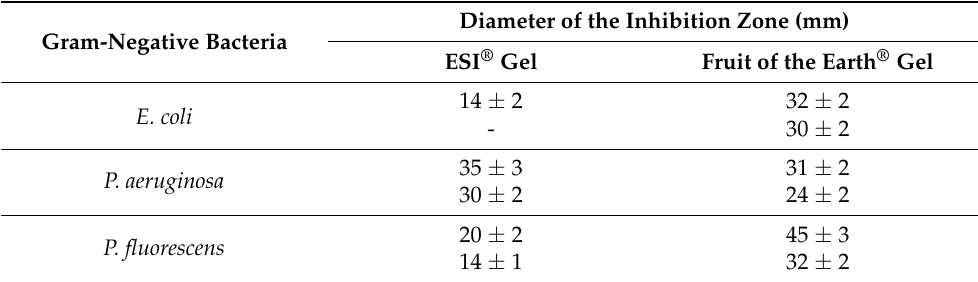
Table 2. Antimicrobial activity of aloes natural and commercial products on Gram-negative bacteria. Diameter of the Inhibition Zone (mm) Gram-Negative Bacteria ESI ® Gel Fruit of the Earth ® Gel 14 ± 2 32 ± 2 E. coli - 30 ± 2 35 ± 3 31 ± 2 P. aeruginosa 30 ± 2 24 ± 2 20 ± 2 45 ± 3 P. fluorescens 14 ±